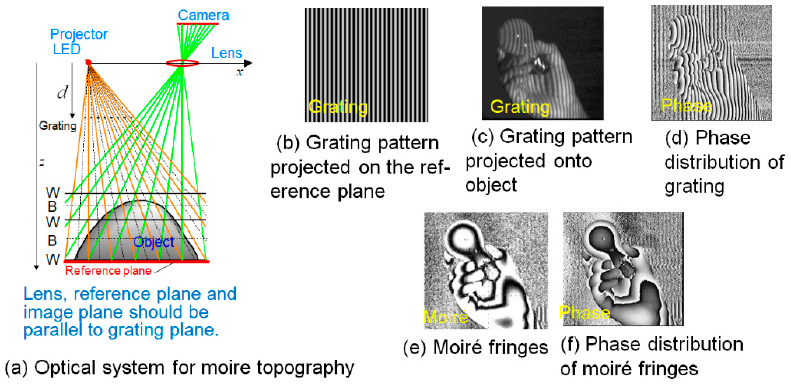
Figure 1. Optical system for shape measurement by the OPPA method [17].